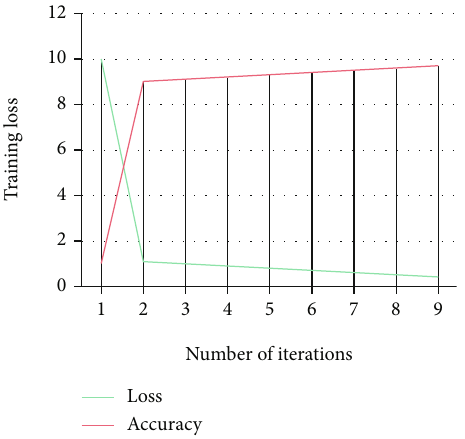
Figure 1: Loss curve and accuracy curve of convolution neural network.